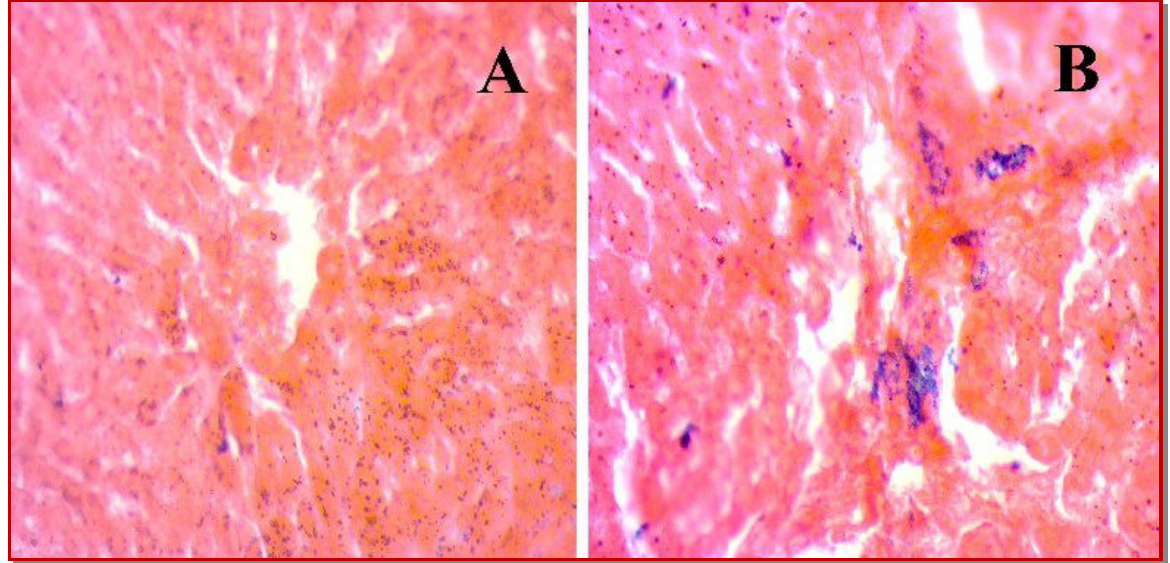
Figure 5: Prussian blue staining showed iron deposition (blue color) in liver of rats treated with CCl 4 . A, Control; B, CCl 4 , Magnifi- cation